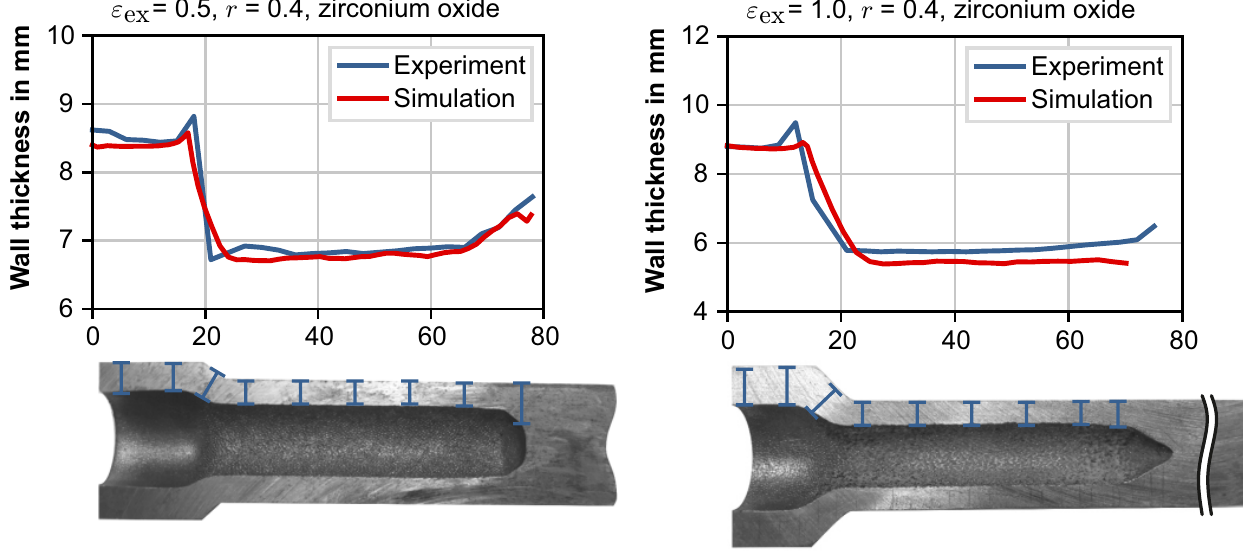
Figure 17. Wall thicknesses measured in experiments and obtained by process